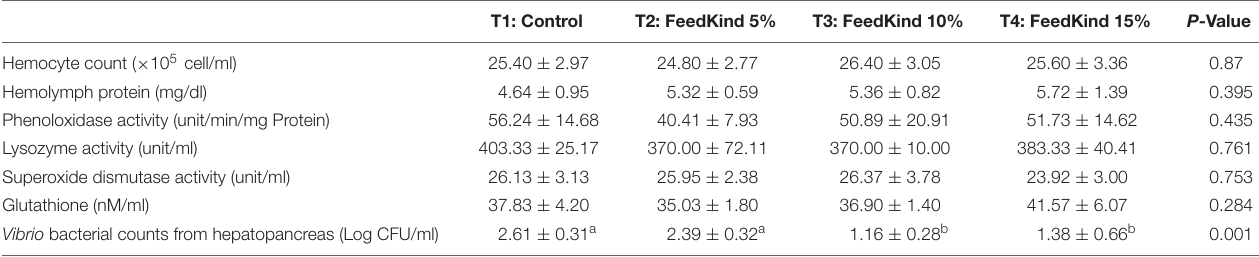
Values with different superscript letters in row indicate significant differences (p < 0.05) between treatments.